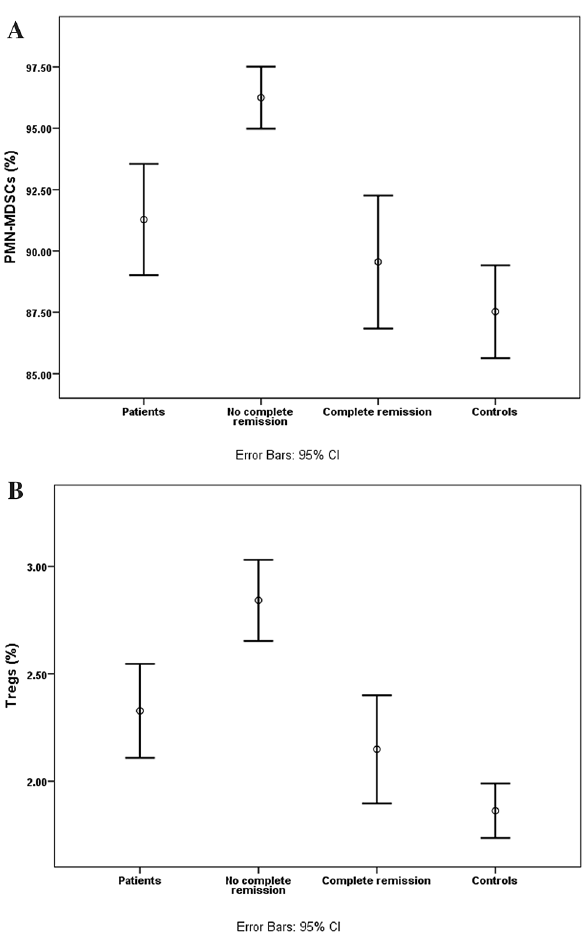
Figure 4. Different levels of ( A ) PMN-MDSCs and ( B ) Tregs among B-ALL patients, patients who did not undergo complete remission, patients showing complete post-induction remission, and healthy